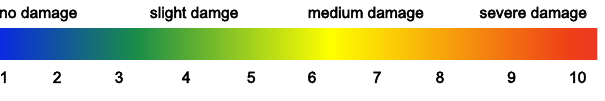
Fig. 4. Assessment values ranging from no damage to severe damage (1–10) derived from crowdsourced photos and geolocated videos.